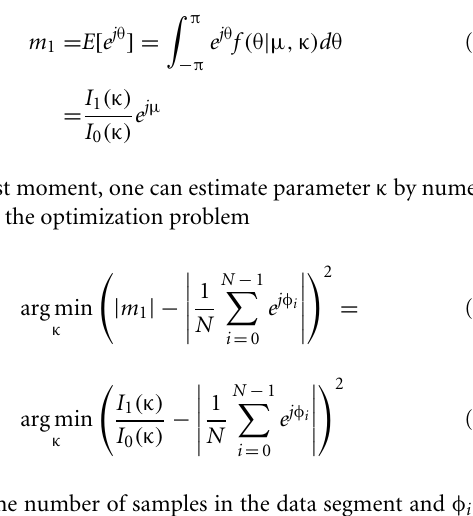
where θ is an angle defined in the interval [− π , π ) and I 0 ( κ )